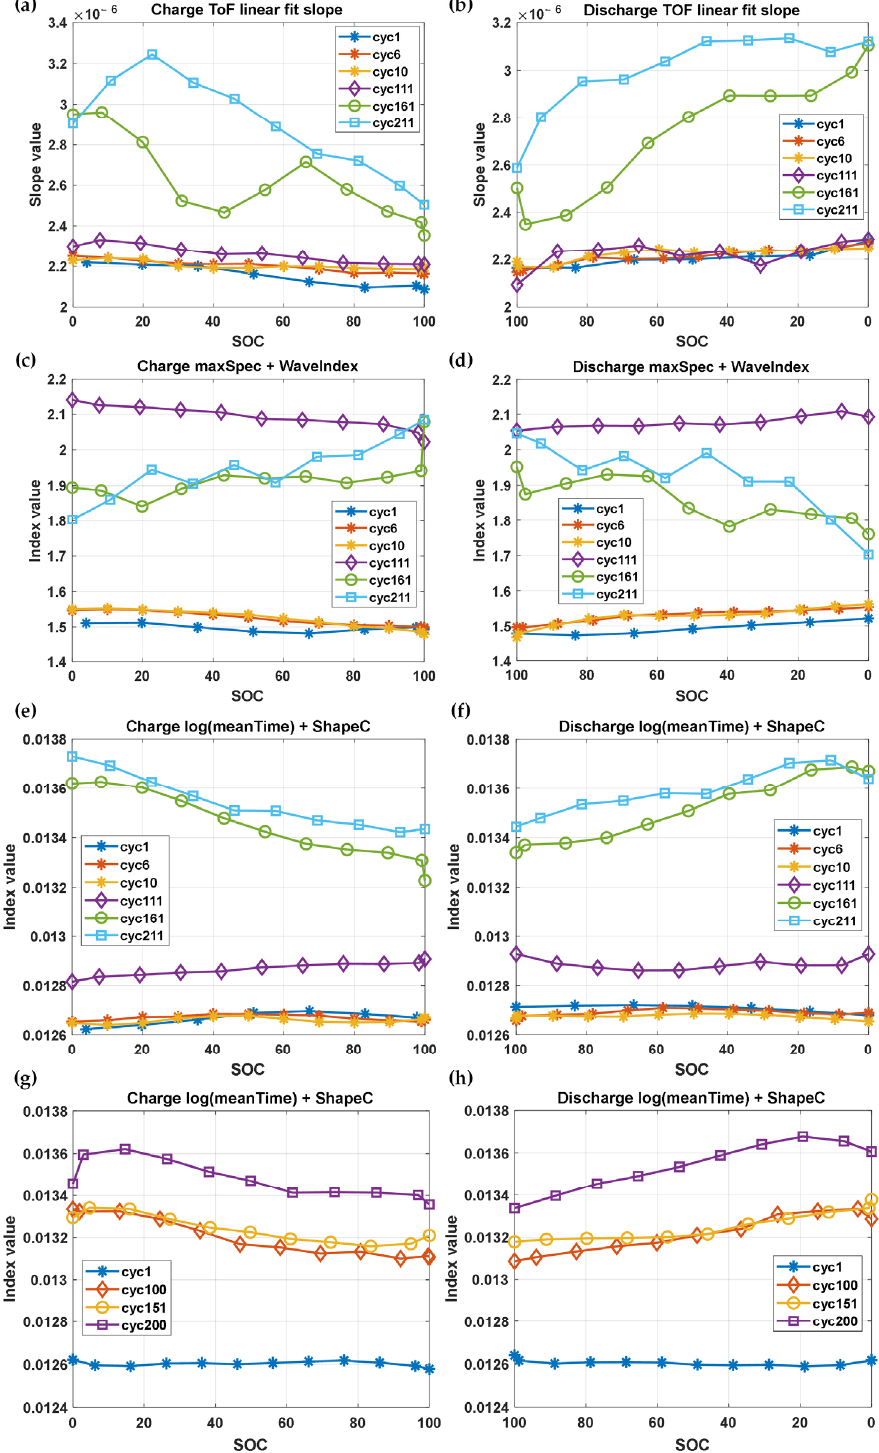
Figure 11. Changes of characteristic parameters of lithium-ion batteries with different aging degrees. (( a – f ) are the change diagrams of charge/discharge characteristic parameters of B0 battery; ( g , h ) are the change diagrams of charge/discharge characteristic parameters of B1 battery). Figure 11e,f respectively shows the change of the “line” characteristic parameter— ”time domain centroid + shape coefficient” during the charge–discharge process of the B0 battery. The value of this characteristic parameter is lower when the battery is fresh.